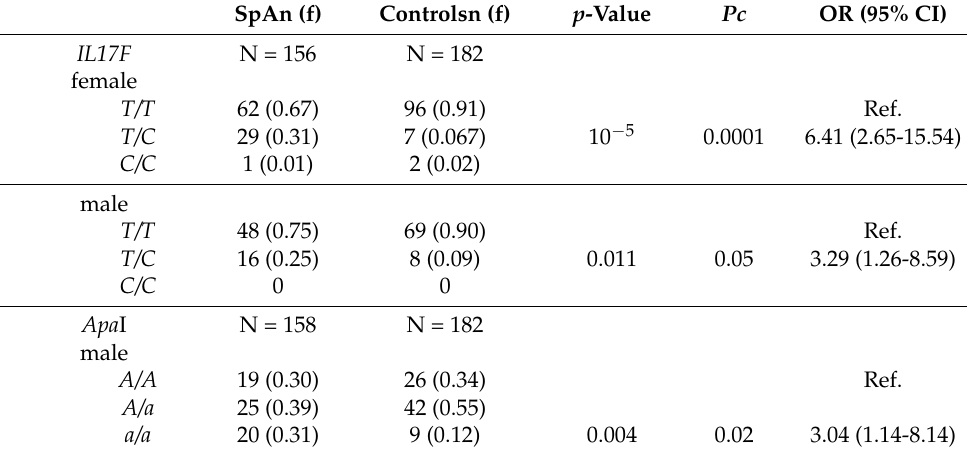
Table 3. Association of IL17F and Apa I polymorphisms with spondyloarthritis (SpA) in HLA-B*27 negative patients compared with same-sex controls.